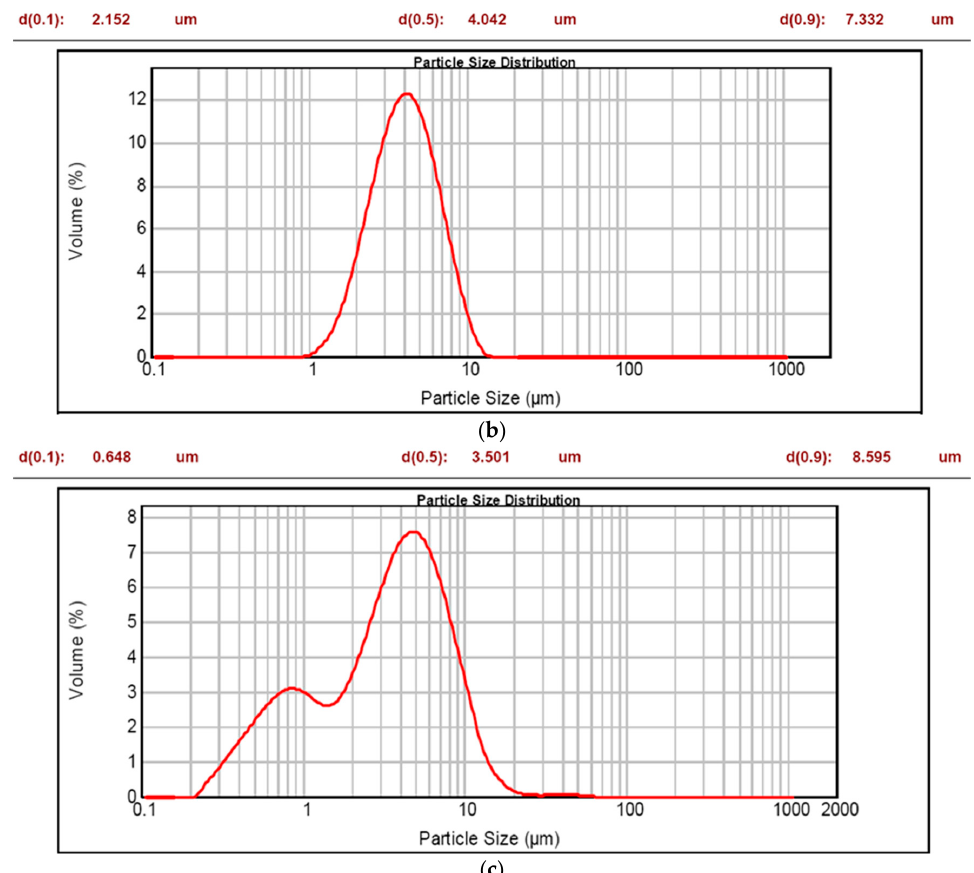
Figure 5. Particle size distribution for a 60 wt. % B35/50 for ( a ) d(0.5) s , ( b ) d(0.5) l , and ( c ) bimodal emulsion.